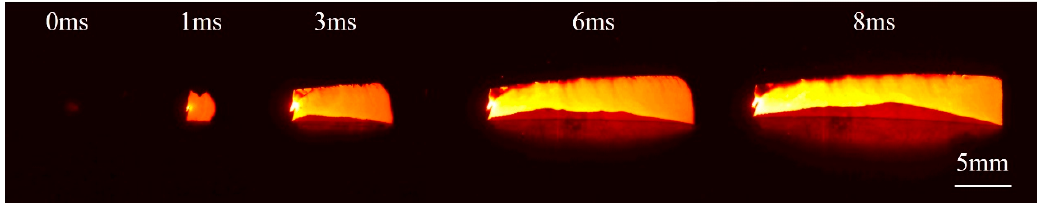
Figure 4. High-speed camera measurement of the RMF reaction speed.